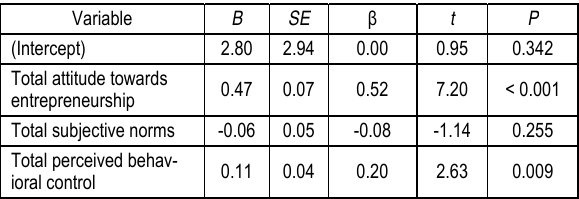
Table 3. Attitude, subjective norms and perceived behavioral controls predicting EI